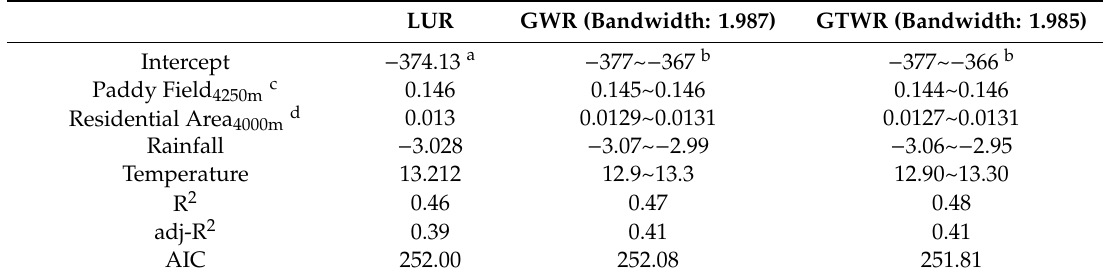
Table 3. Comparison of final model for NO 2 using LUR, GWR and GTWR.